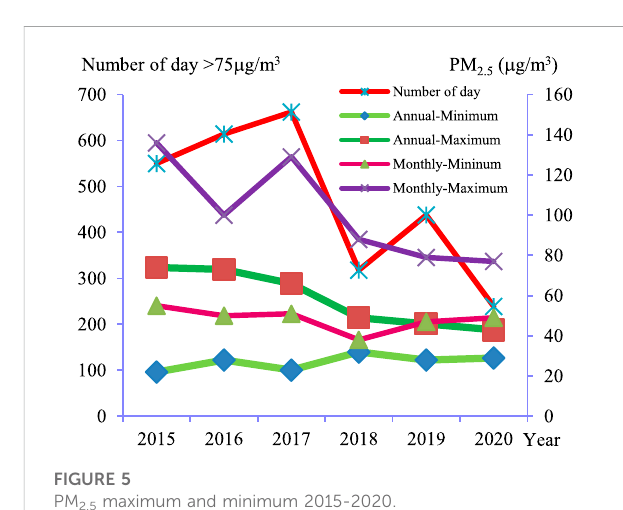
FIGURE 4 PM 2.5 concentration gap 2015-2020.